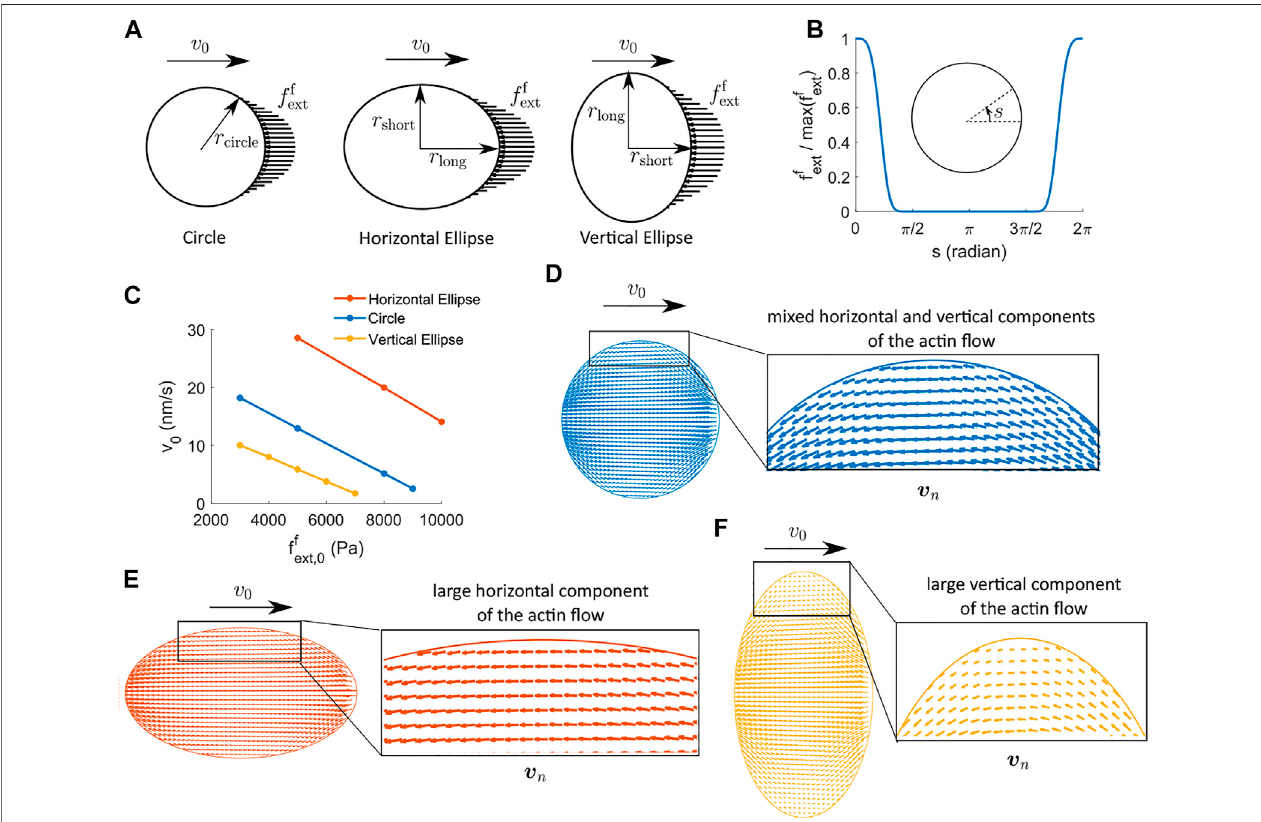
FIGURE 5 | Two-dimensional cell velocity and effective force generation under actin-driven cell migration when actin polymerization happens at the front regime of thecellanddepolymerizationhappensatthebackregionofthecell. (A) Schematicsoftheexternalforceperunitareaappliedtothefrontregionofthecells.Weusethree cell shapes: circle, horizontal ellipse, and vertical ellipse. The three cells have the same areas. r circle = 14.92 μ m, r long = r circle / a , and r short = ar circle , where a = 0.75 is a parameterfortheaspectratiooftheellipse. (B) Pro fi leoftheexternalforce. f f ext /max ( f f ext ) (cid:2) g ( s ) istheshapepro fi leoftheexternalforceappliedatthefrontregime of the cell. α ext = 0.2 π . (C) Actin-driven cell migration as a function of the magnitude of the external force, f f ext , 0 , for three different cell shapes. (D – F) The spatial pro fi le of theactinnetworkvelocity, v n ,intheabsenceofexternalforcesforthecircle,horizontalellipse,andtheverticalellipsecells,respectively.Theactinvelocityinthehorizontal ellipse-shaped cell has a relatively large component along the direction of migration. The actin velocity in the vertical ellipse-shaped cell has a relatively large component perpendicular to the direction of cell